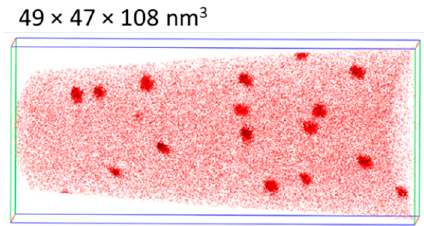
Figure 4. APT solute atom map for the RPV base material irradiated at high flux (BH). Cu, Ni and Si atoms are represented in red. Clusters are highlighted using a threshold of 3.6 at%.